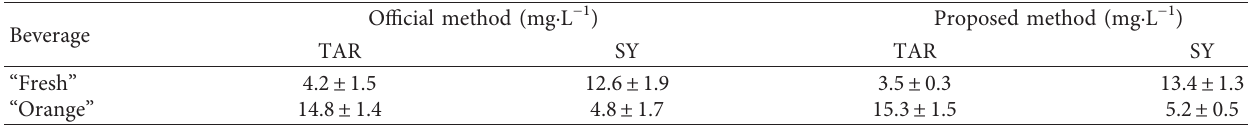
Figure 5: Elution profile obtained for analysis of “Fresh” and “Orange” beverages. Eluent: 2 mmol · L − 1 KH acetonitrile with step increase to 10% after 17mL. The rate of the eluent is 1mL · min − 1 . The detector wavelength is 427nm and 484nm for TAR and SY, respectively. Table 1: Results for the determination of dyes in beverages “Fresh” and “Orange” ( n � 3, P � 0 . 95).